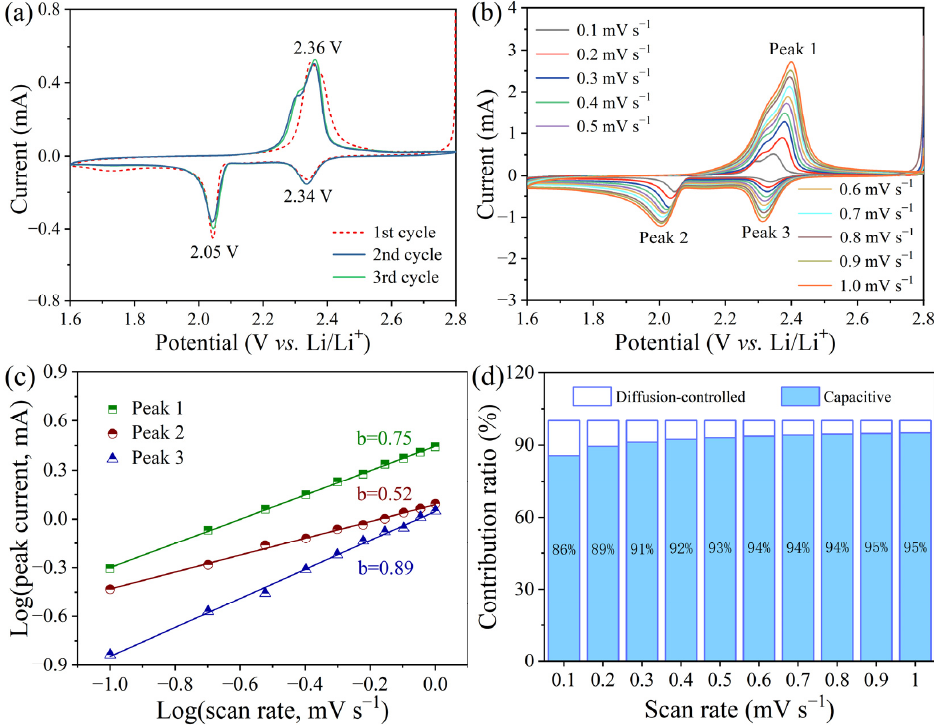
Figure 8. ( a ) Initial five CV curves of VN/S@PANI cathode at a scan rate of 0.1 mV s − 1 . ( b ) CV curves of VN/S@PANI cathode at 0.1 to 1.0 mV s − 1 . ( c ) The log (i ) vs. log( v ) of VN/S@PANI cathode. ( d ) Contribution ratio of capacitance control and diffusion control.